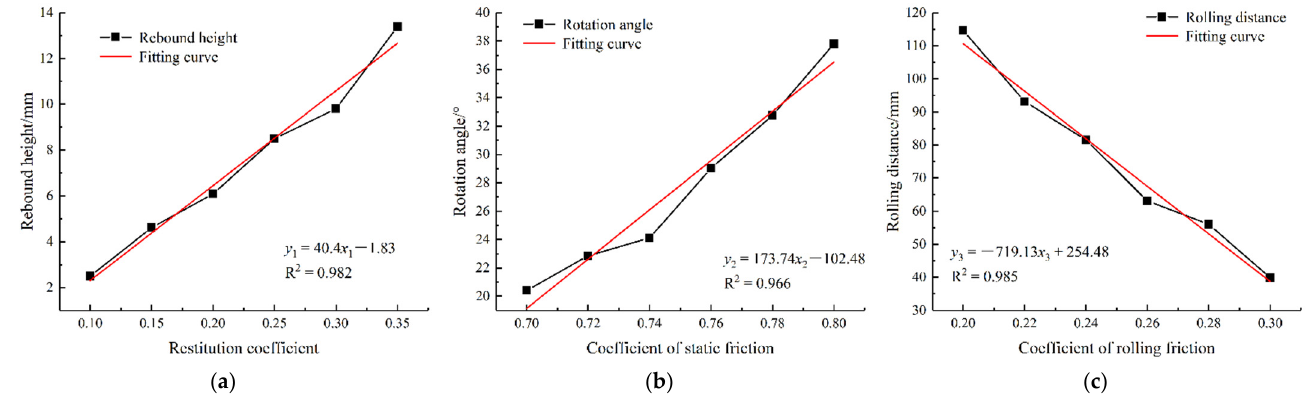
Figure 3. Fitting curves of each contact parameter to the corresponding physical test values. ( a ) The fitting curves of seed–powder collision recovery coefficient x 1 and seed rebound height y 1 ; ( b ) fitting curve of static friction coefficient x 2 of seed–powder and rotation angle y 2 of seed inclinometer; ( c ) seed–powder rolling friction coefficient x 3 and seed horizontal rolling distance y 3 fitting curve.